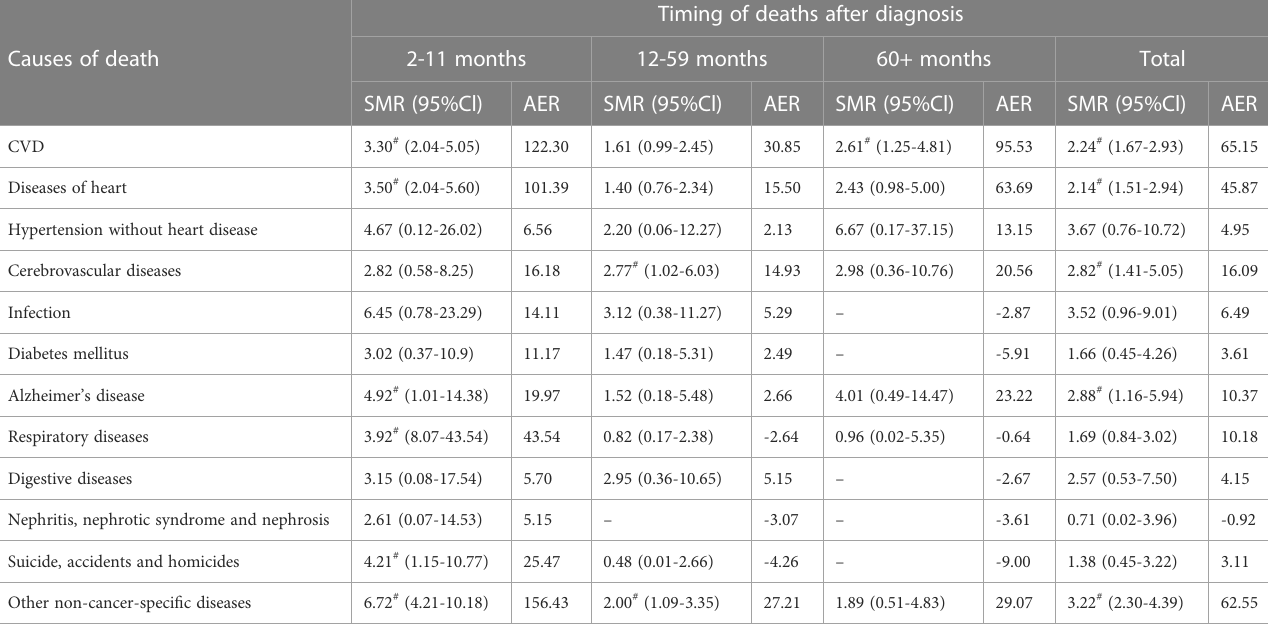
TABLE 3 SMRs and AERs for non-cancer-speci fi c causes of death after PCNS-DLBCL diagnosis.